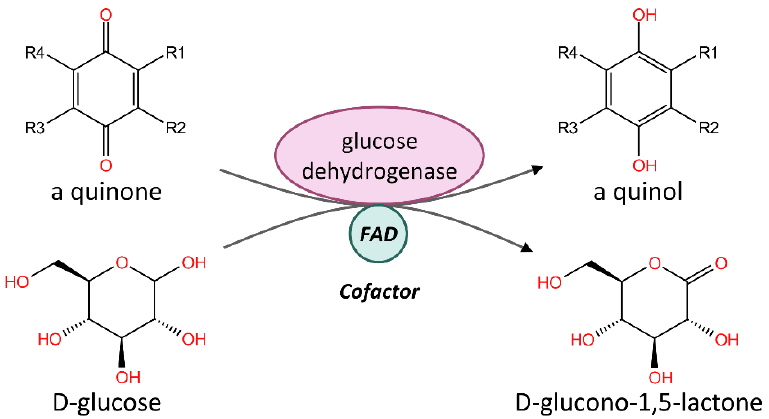
Figure 8. Glucose dehydrogenase with FAD as a cofactor catalyzes quinone and D-glucose to quinol and D-glucono-1,5-lactone in Drosophila melanogaster . This schematic diagram is based on the function of Glucose dehydrogenase (FAD, quinone) (UniprotID: P18173) in the Uniprot